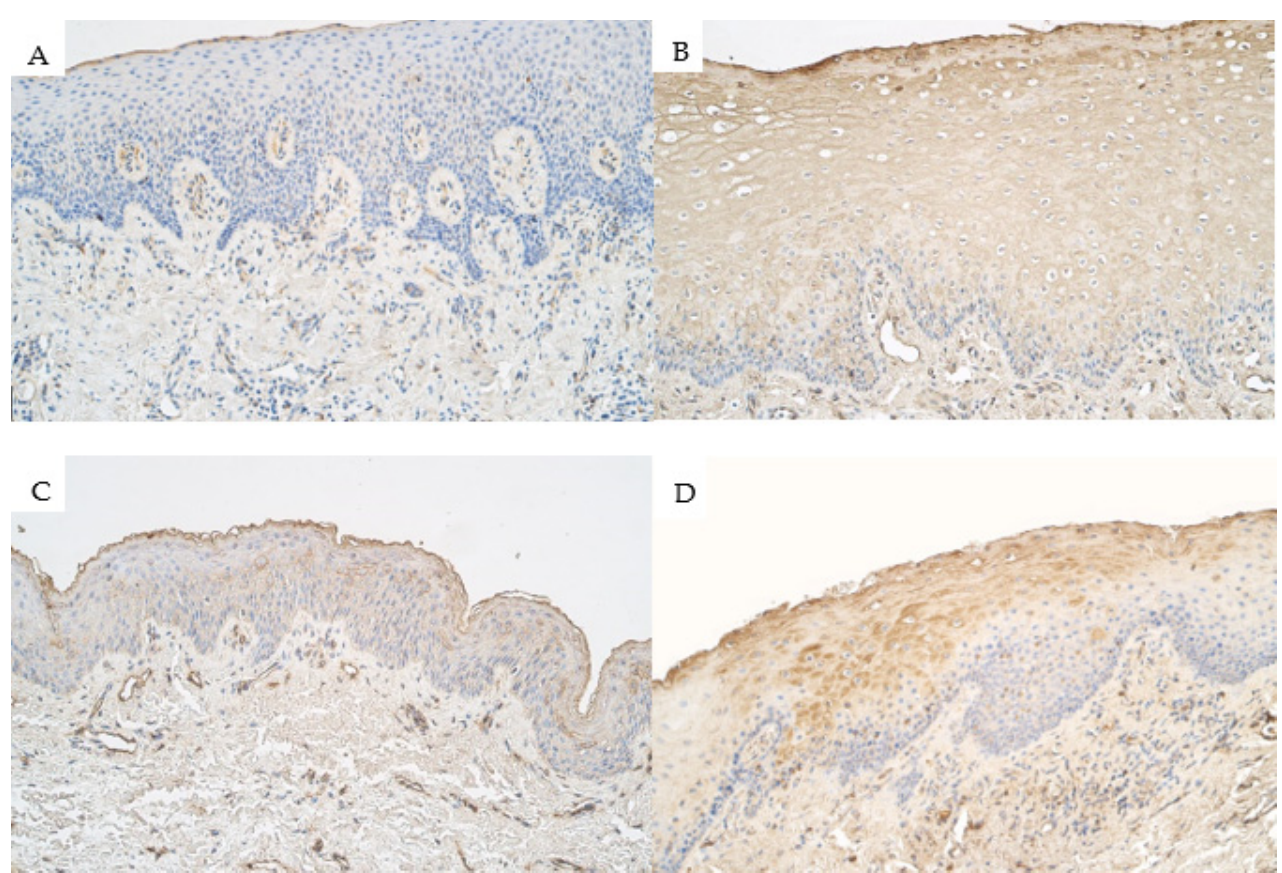
Figure 4. Immunoreactive structures for receptor-like tyrosine kinase ( RYK ) in cleft affected tissue. ( A ) Control group tissue with a few RYK -containing epitheliocytes in the epithelium and a few RYK -containing cells in the connective tissue, RYK IMH, 200×. ( B ) Unilateral cleft lip affected tissue with numerous RYK -positive epitheliocytes in the epithelium and moderate to numerous RYK -containing cells in the connective tissue, RYK IMH, 200×. ( C ) Bilateral cleft lip affected tissue with a moderate number of RYK -positive structures in the epithelium and moderate to numerous RYK -positive structures in the connective tissue, and also in the endothelium, RYK IMH, 200×. ( D ) Isolated cleft palate affected tissue with moderate to numerous RYK -containing epitheliocytes within the epithelium and a moderate number RYK -containing cells in the connective tissue, RYK IMH, 200×.